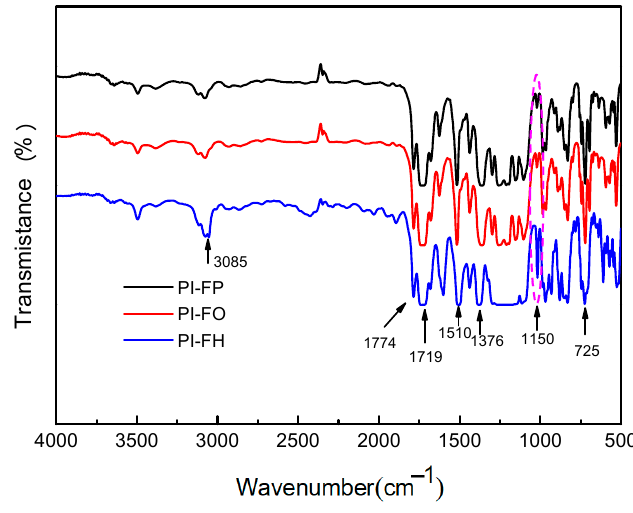
Figure 2. FT—R spectra of PI films.